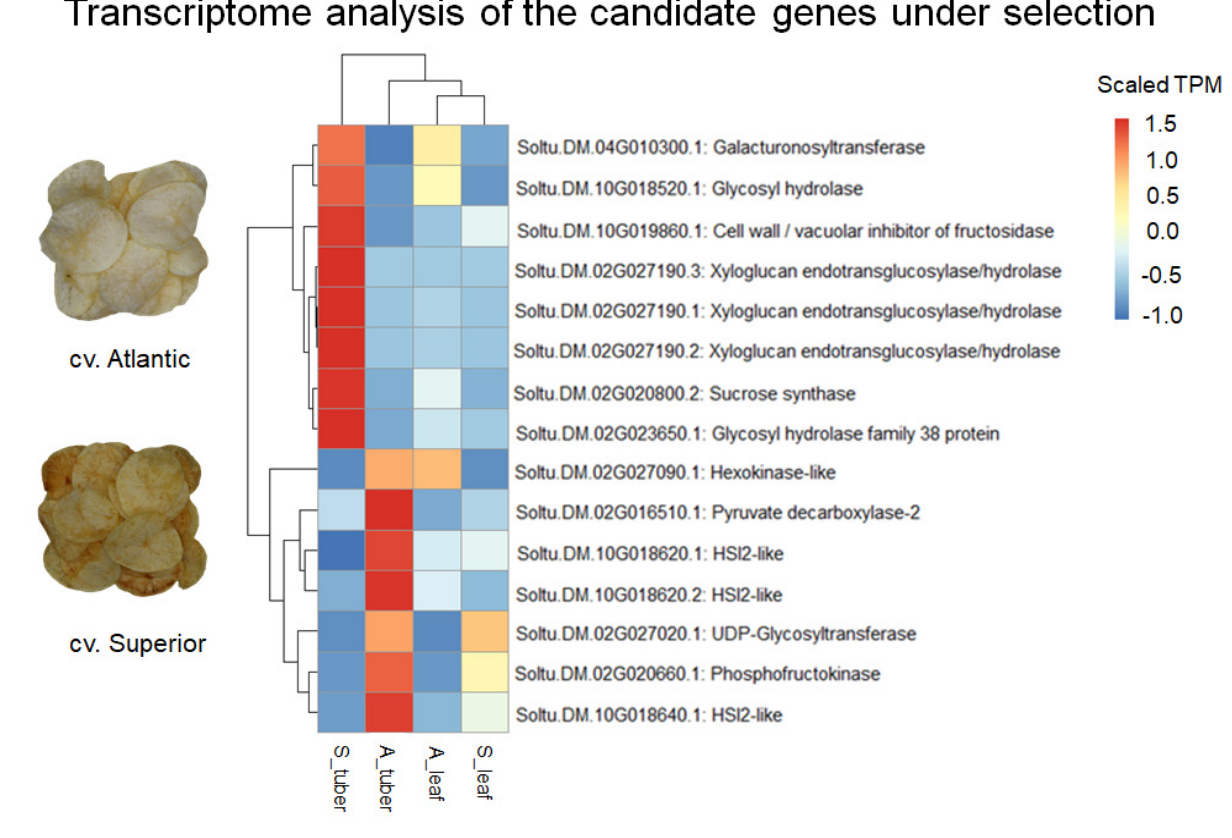
Figure 5. Transcriptome analysis of the candidate genes under selection by more than two approaches among GWAS, XP-CLR, PCAdapt, iHS and XP-EHH. The heatmap shows candidate genes with differential expression of >3.0-fold for the Transcripts Per Kilobase Million (TPM) values between two cultivars. A_leaf; leaf tissue of cv. Atlantic, S_leaf; leaf tissue of cv. Superior, A_tuber; tuber tissue of cv. Atlantic, S_tuber; tuber tissue of cv.